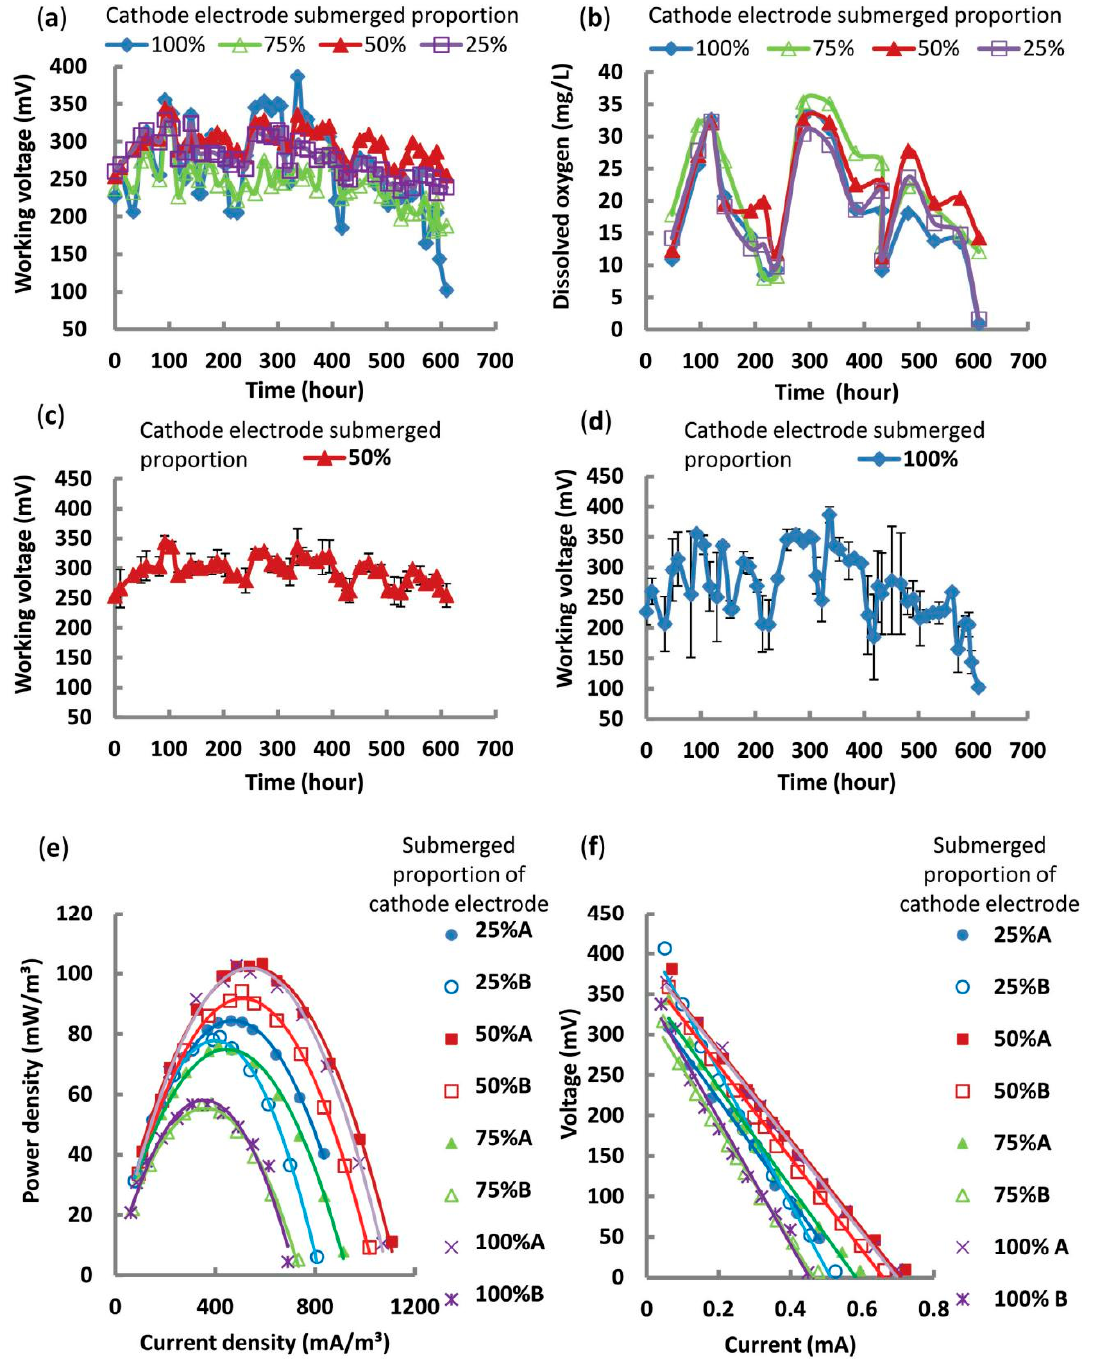
Figure 2. Electricity generation by the microbial fuel cell (MFC) reactors with the cathode electrodes submerged at the proportions of 25%, 50%, 75%, and 100% on 1 k Ω external resistance. ( a ) Working voltage; ( b ) Dissolved oxygen in the catholyte; ( c ) Working voltage with the 50% submerged cathode electrodes; ( d ) Working voltage with the 100% submerged cathode electrodes ( e ) Power density; ( f ) Polarization curve. A and B refer to the data from the two identical reactors in the same test group. The data showed in ( a – d ) were the average values of the two identical MFCs within each test group.